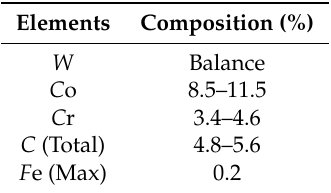
Table 1. Chemical composition of WOKA-3653 (wt %) [19].